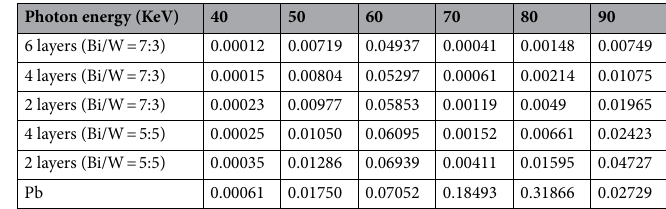
Table 1. The dependence of the X-ray transmittance (I/I 0 ) on layer thickness ratios (7:3 and 5:5) (1 mm thick).